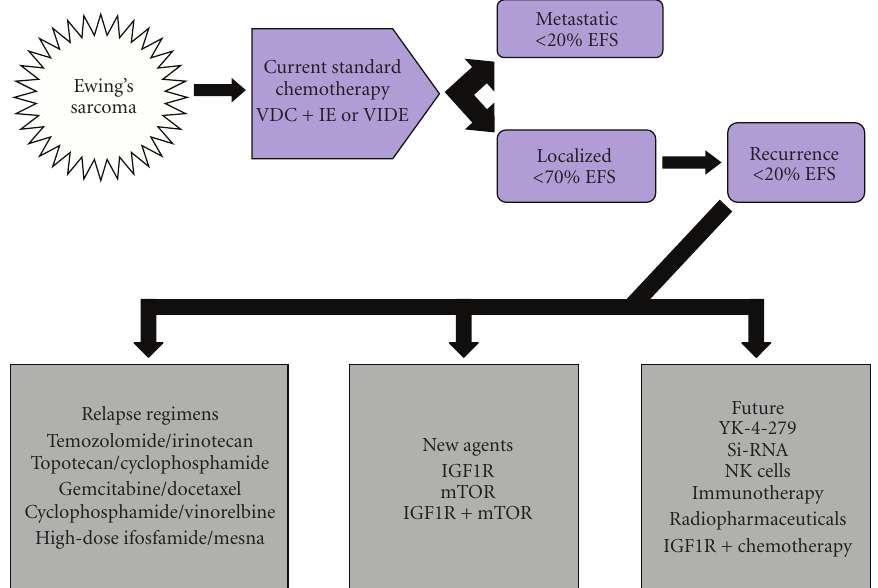
Figure 1: Current and future EWS treatment options. Current treatment of EWS typically employs VAC+IE or VIDE regimens. Local control includes surgery and/or radiation therapy. With this regimen, patients with only local disease have about 70% disease-free survival (EFS). However, patients with EWS who have metastatic disease or who have recurrence have < 20% EFS. Second-line relapse regimens as shown below often provide temporary benefit. New agents against IGF1R and /or mTOR are currently available. Future options include innovative targeted therapies. V: vincristine; D: doxorubicin; C: cyclophosphamide; I: ifosphamide/mesna; E: etoposide; IGF1R insulin-like growth factor 1 receptor inhibitor; mTOR: mammalian target of rapamycin